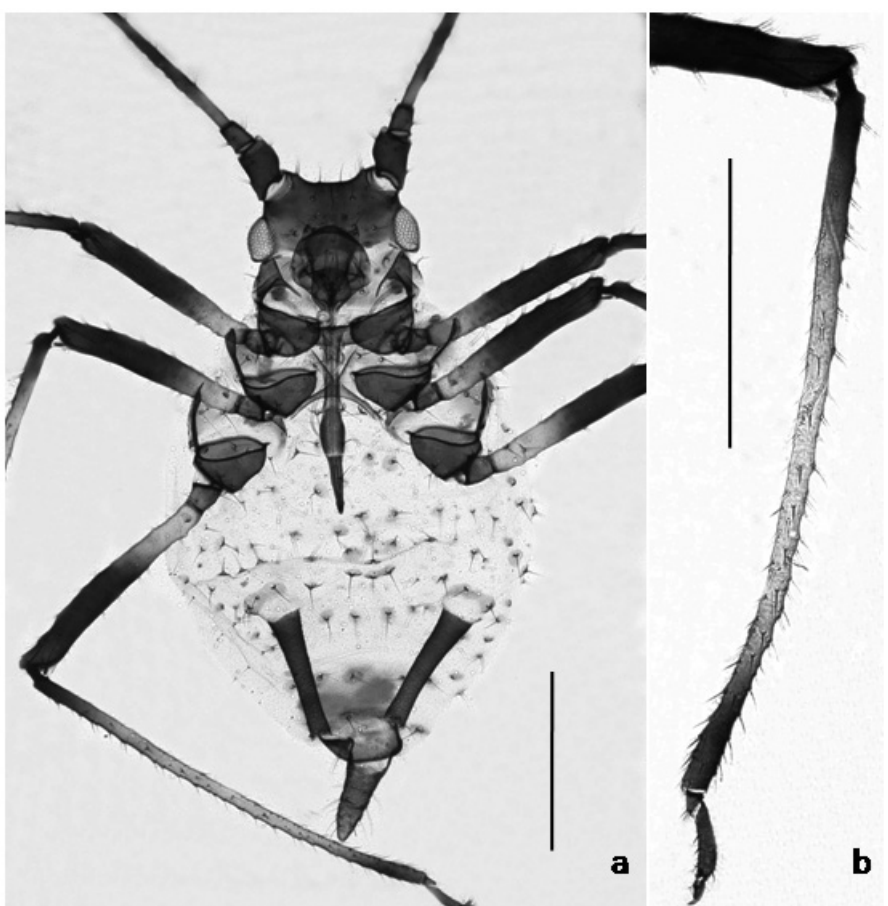
Figure 2. a Macrosiphoniella aetnensis , apterous viviparous: body shape and pigmentation b hind tibia. Scale bars 0.5